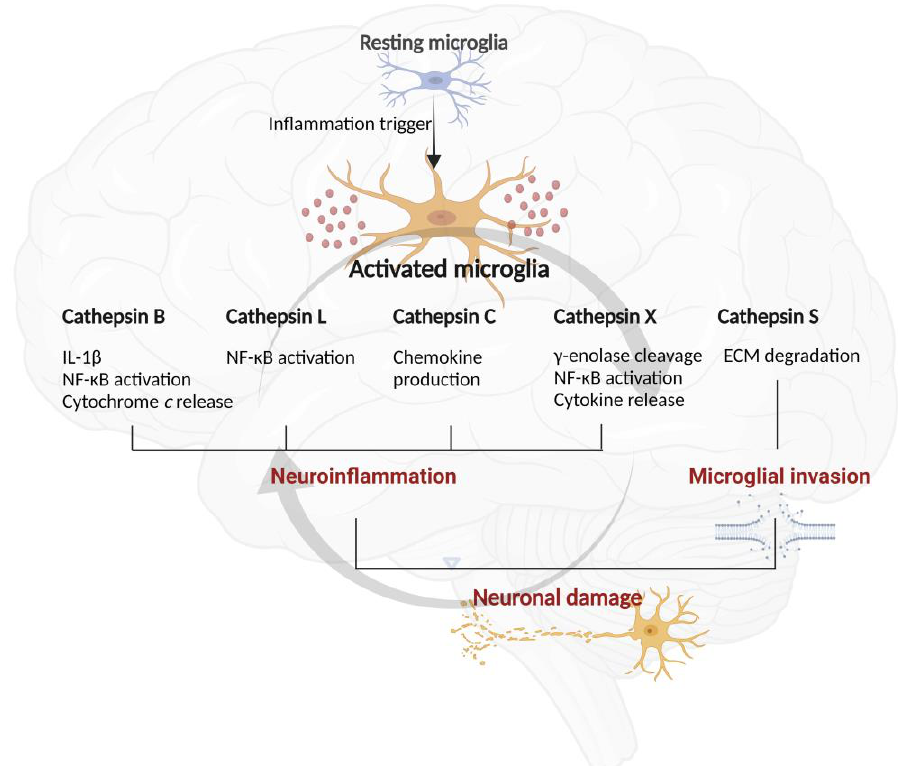
Figure 3. The involvement of microglial cathepsins in inflammation-induced neurodegeneration. Cysteine cathepsins can be released from activated microglia following various toxic insults, and their activity through various pathways may be lethal to neurons. Extracellular cathepsins B, L, and X promote inflammation through the nuclear factor-kappa B (NF- κ B) pathway. Cathepsin B also promotes inflammation by participating in the maturation of interleukin- 1β (IL- 1β ) and cleavage of pro-apoptotic Bid protein, which leads to the release of cytochrome c . Cathepsin X also cleaves the C- terminal end of γ -enolase, abolishing its neurotrophic activity, and releases pro-inflammatory cytokines. Cathepsin C induces chemokine production. Extracellular cathepsin S assists microglial migration by degrading extracellular matrix (ECM) components. The relationship between microglia activation and neuronal death is cyclical.